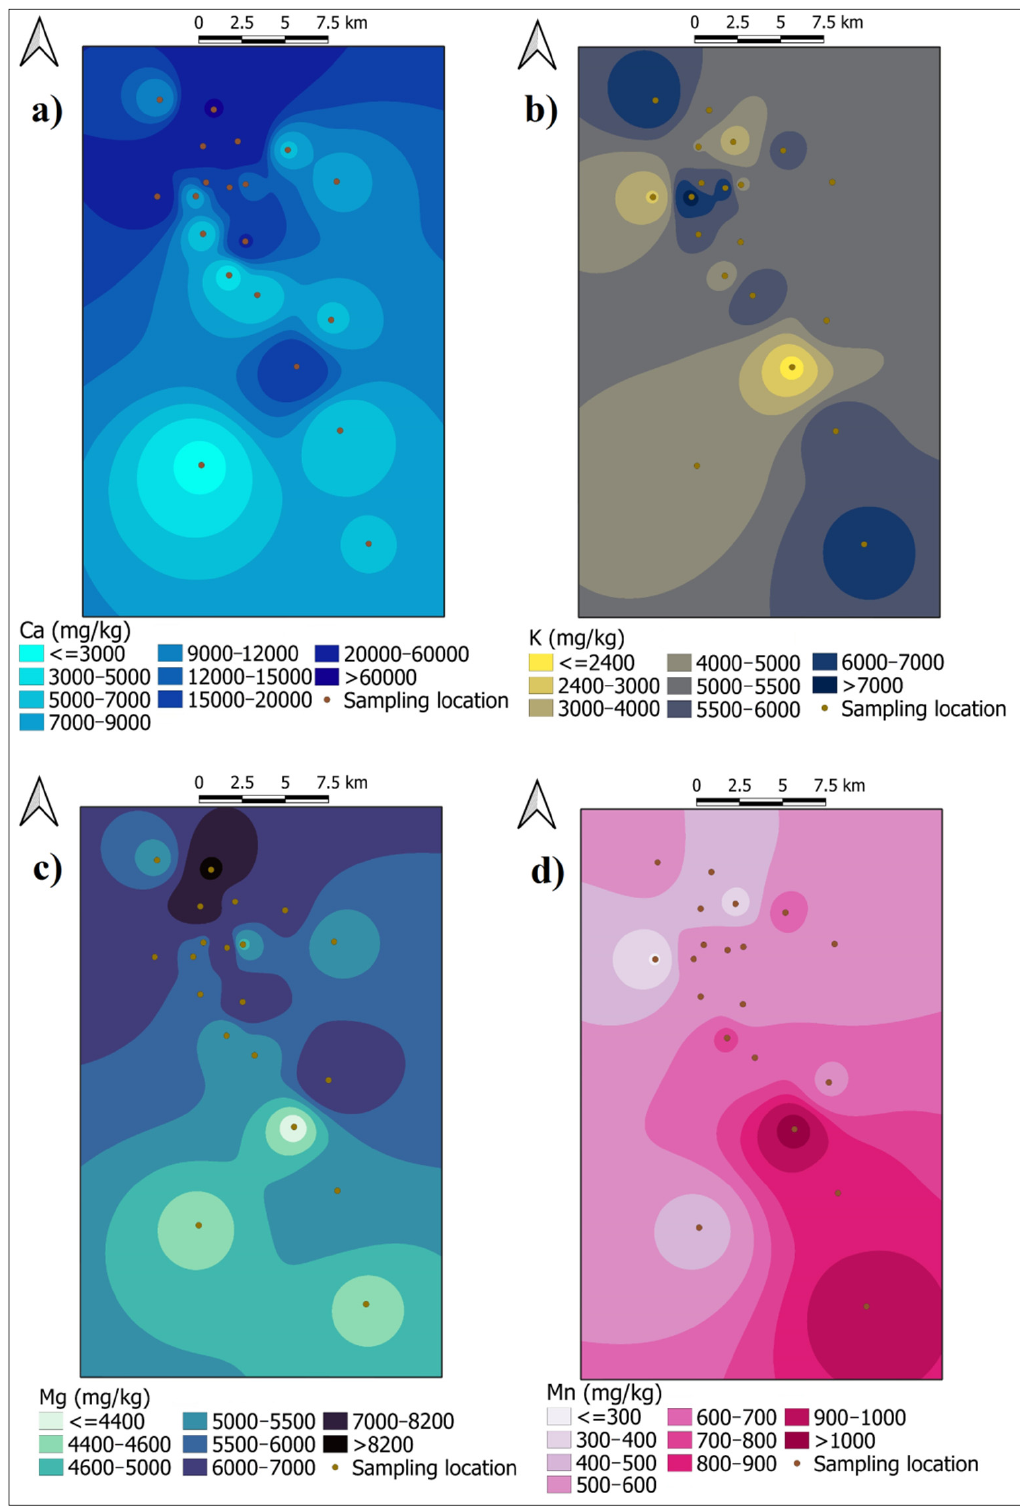
Figure 4. The spatial distribution of ( a ) Ca, ( b ) K, ( c ) Mg, and ( d ) Mn in soil. Concentrations of Co, Cu, and Ni were above corrected target values in almost all Target and intervention levels of As and metals proposed by Dutch standard for soil soil samples. However, soils in Serbia are naturally rich in these elements and even in [41] and Serbian Soil Quality Regulation were corrected for each particular sample based agricultural soil and soils that are in rural areas or distant from pollution sources have on its organic matter and clay content [42]. Accordingly, concentrations of As (759.6 concentrations of Co, Cu and Ni higher than target values [30,43]. Concentrations of mg/kg), Cd (5.42 mg/kg), and Pb (4297 mg/kg) in soil sampled at location Avala 1 were significantly higher than remediation values, which classifies this soil as highly contam- inated. However, the origin of As, Cd, and Pb at this location is probably not anthropo-